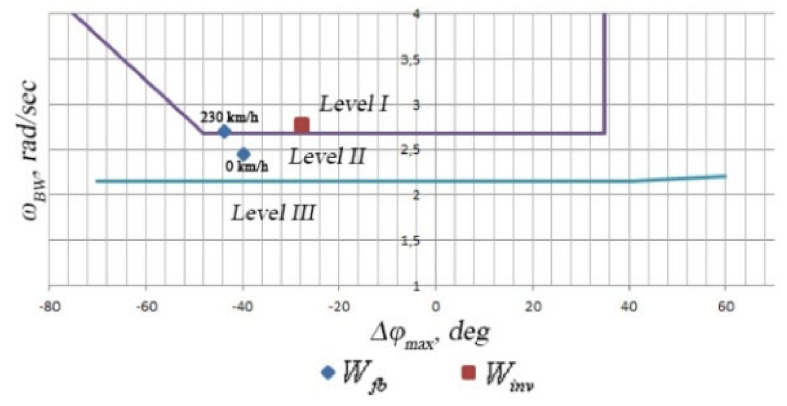
Figure 14. New MAI criterion.